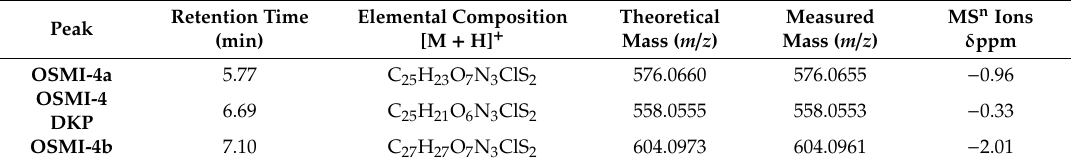
Table 1. High resolution UHPLC–PDA–Q-Orbitrap identification of compounds OSMI-4a, OSMI-4b, and OSMI-4 DKP.